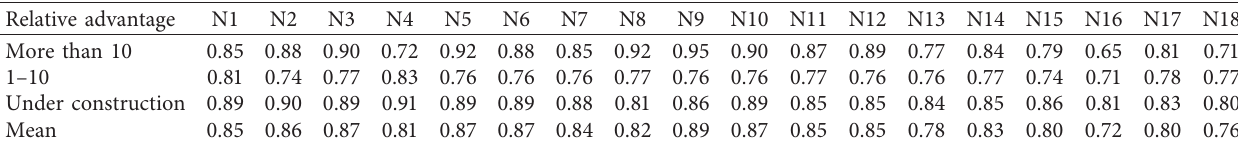
Table 6: The relative advantage score of each BIM application